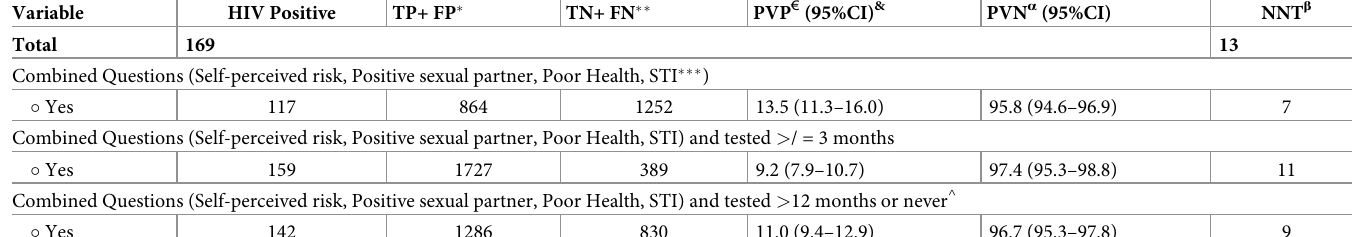
Table 7. Predictive value positive and predictive value negative for combined HIV testing services table screening questions, Zimbabwe, 2021. (N = 2116).